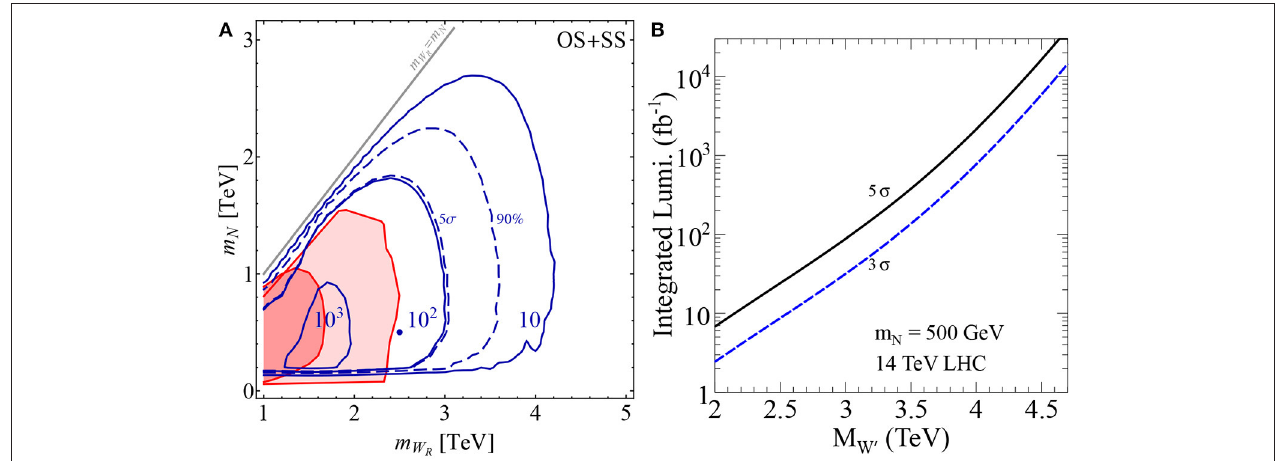
FIGURE 18 | Discovery potential at 14 TeV LHC of W R and N in (A) the minimal LRSM as in Figure 16A after L as in Figure 16B